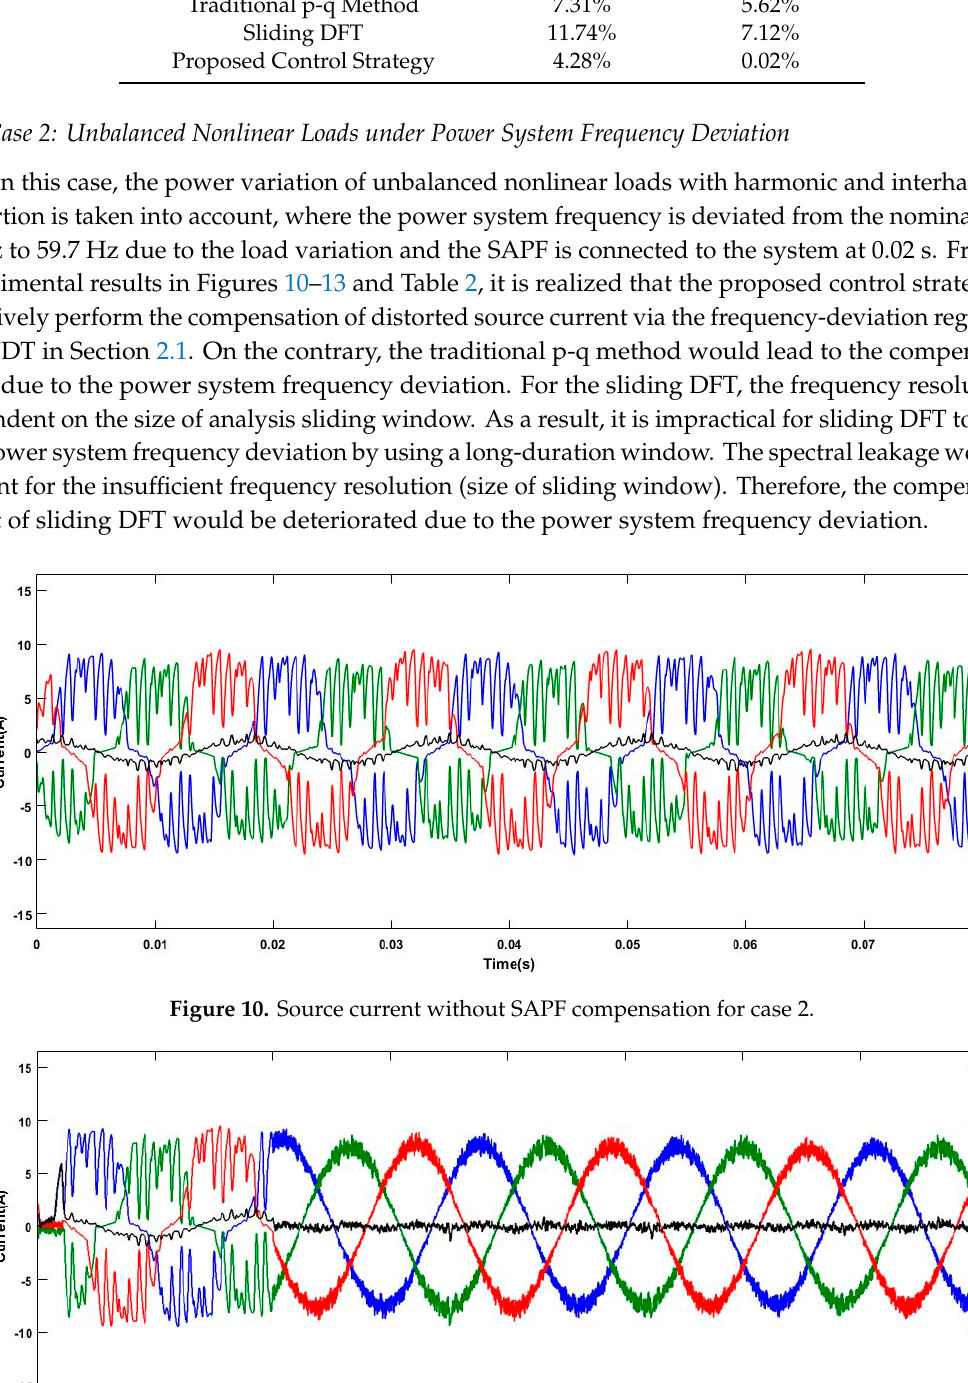
Figure 12. Compensation result with the sliding DFT for case 2. Figure 13. Compensation result with the proposed control strategy for case 2. Table 2. Compensation results for case 2. Compensation Control Method